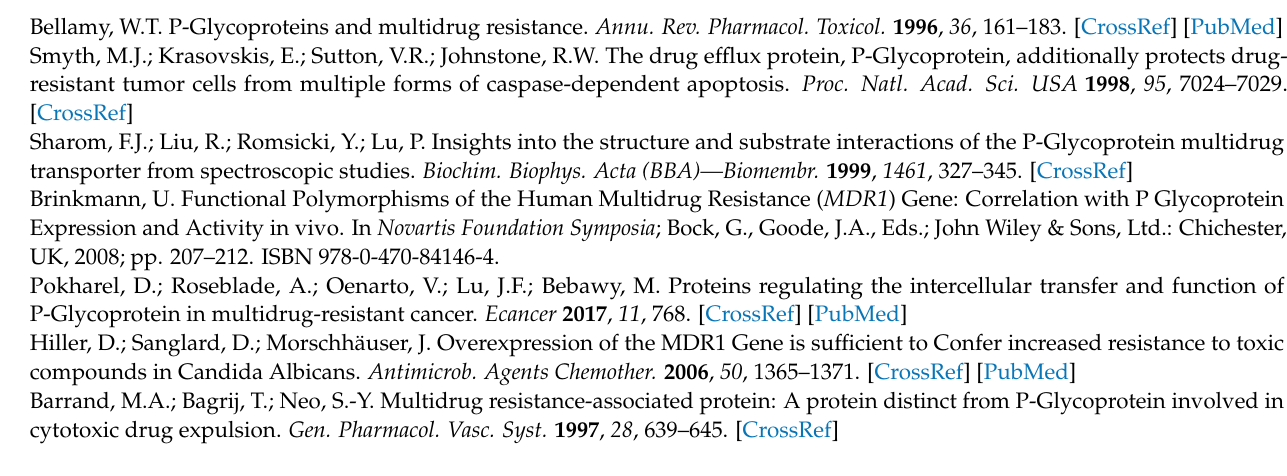
Figure S2: Compound K2 : Se-(2-oxopropyl) 2-fluorobenzoselenoate, Figure S3 : Compound K3: Se-(2- oxopropyl) 4-bromobenzoselenoate, Figure S4: Compound K4 : Se-(2-oxopropyl) 2-(trifluoromethyl) benzoselenoate, Figure S5: Compound K5 : Se-(2-oxopropyl) 3-(trifluoromethyl)benzoselenoate, Figure S6: Compound K6 : Se-(2-oxopropyl) 3-chloro-4-fluorobenzoselenoate, Figure S7: Compound K7 : Se-(2-oxopropyl) 4-(tert-butyl)benzoselenoate, Figure S8: Compound K8 : Se-(2-oxopropyl) 2,4,5- trifluorobenzoselenoate, Figure S9: Compound N1 : Se-(cyanomethyl) thiophene-2-carboselenoate, Figure S10: Compound N2 : Se-(cyanomethyl) 3-fluorobenzoselenoate, Figure S11: Compound N3 : Se-(cyanomethyl) 4-bromobenzoselenoate, Figure S12: Compound N4 : Se-(cyanomethyl) 2- (trifluoromethyl)benzoselenoate, Figure S13. Compound N5 : Se-(cyanomethyl) 3-(trifluoromethyl) benzoselenoate, Figure S14. Compound N6 : Se-(cyanomethyl) 3-chloro-4-fluorobenzoselenoate, Figure S15. Compound N7 : Se-(cyanomethyl)